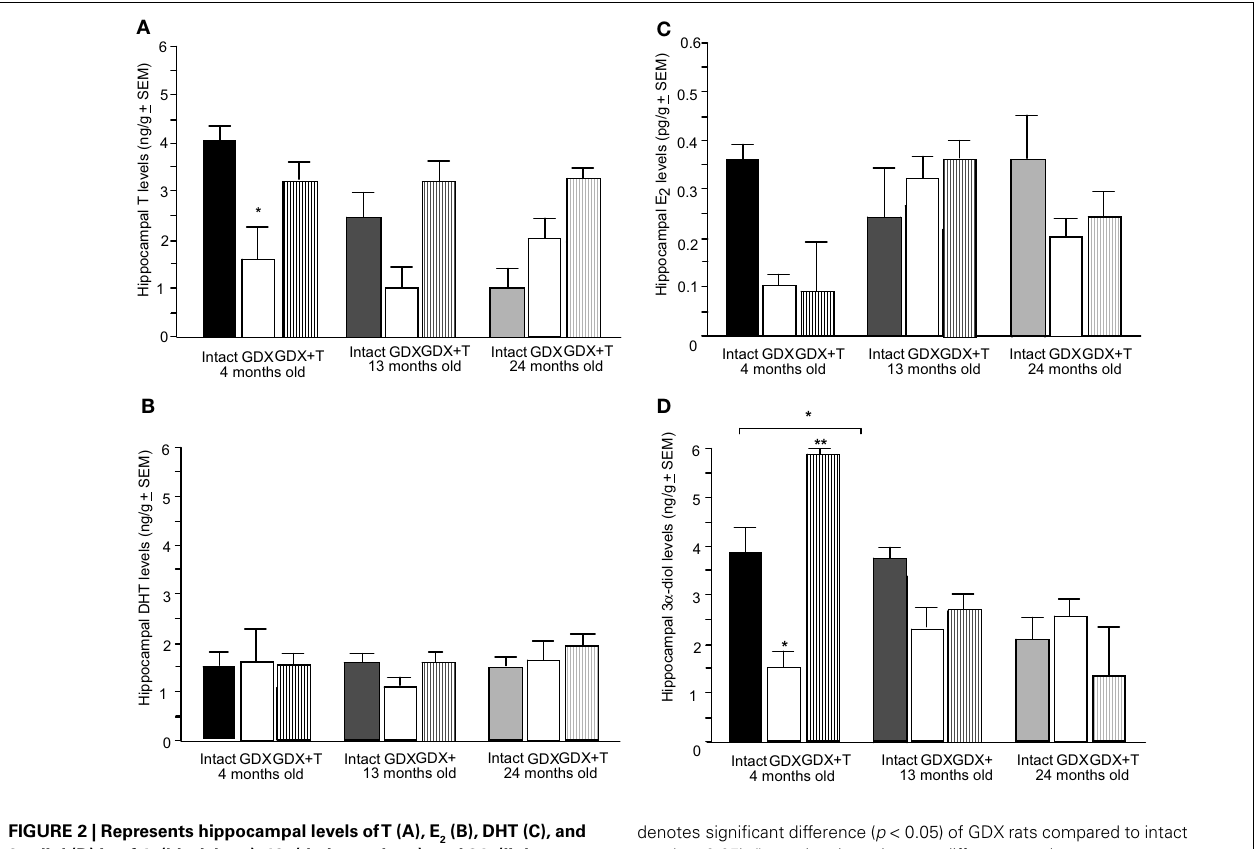
FIGURE 2 | Represents hippocampal levels of T (A), E 3 α -diol (D) in of 4- (black bars), 13- (dark grey bars), and 24- (light grey bars) month-old rats that were left intact (solid bars), GDX (white bars), or GDX and T-replaced (striped bars). * over individual bars